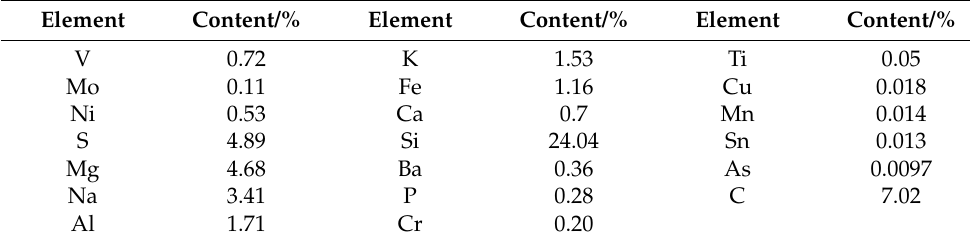
Table 2. Chemical multielement analysis.